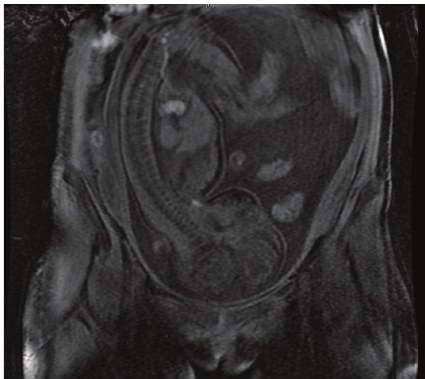
Figure 2: MRI showing coronal view of resolution of right iliacus muscle abscess following percutaneous drainage and antibiotics during pregnancy.